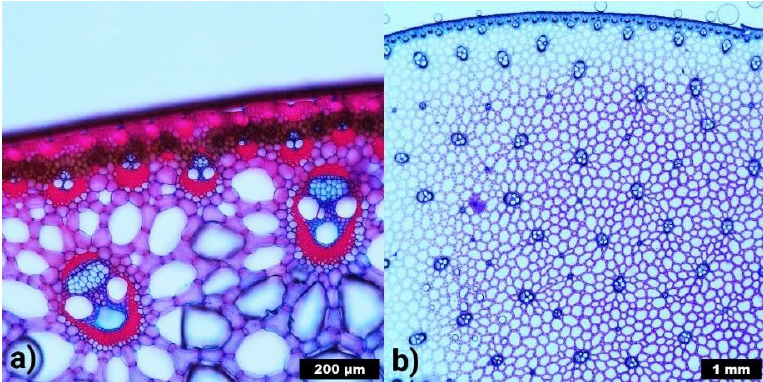
Figure 4. Microscopic images of cross-sections of Cyperus papyrus L. stems. ( a ) Detail of the outer region of papyrus pith. Lignified areas are colored red with Safranin-O, cellulosic areas are stained with Astra Blue and appear blue/pink. Scale bar 200 µm. ( b ) Overview of the structure of papyrus pith, stained with toluidine. The denser vascular bundles appear darker. Scale bar 1 mm.